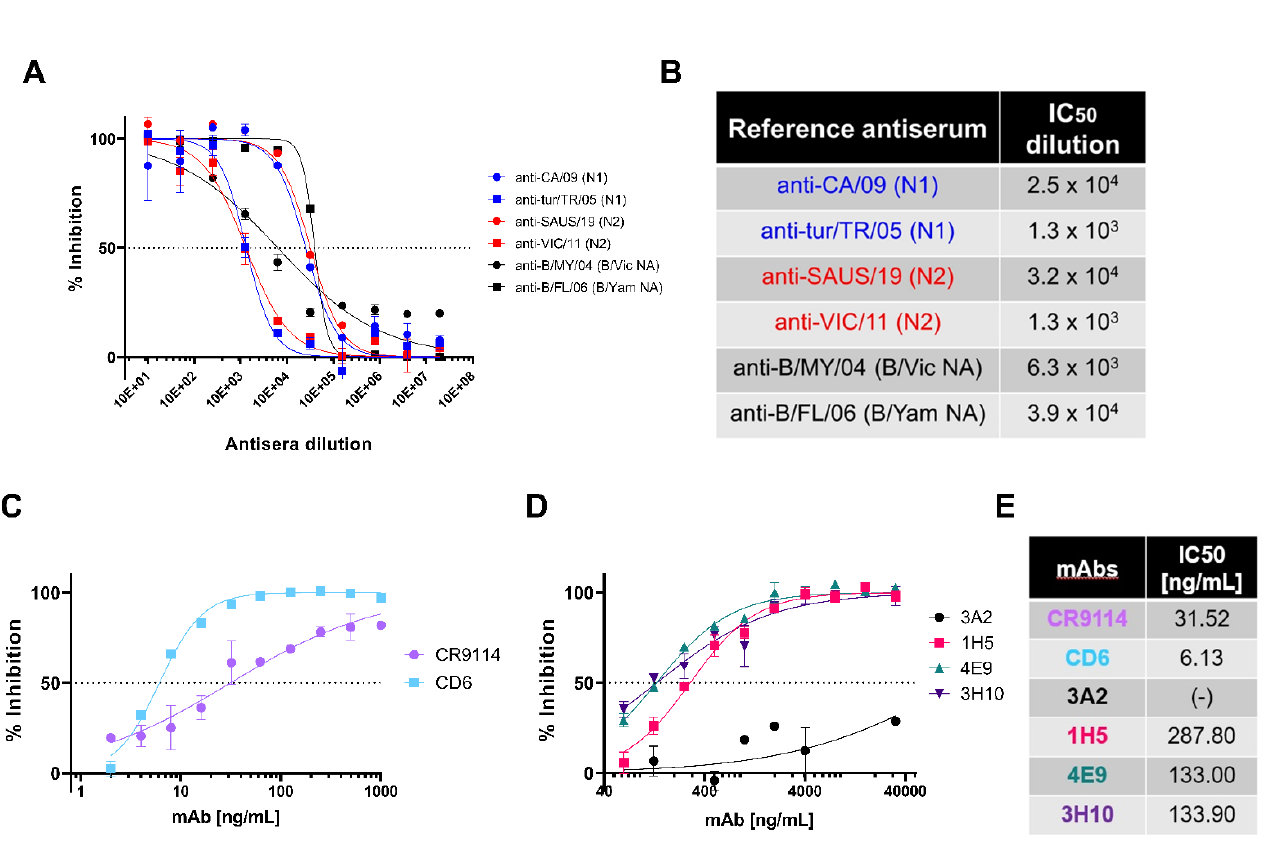
Figure 3. In vitro inhibition of NA pseudotypes by antisera and monoclonal antibodies. ( A ) In vitro inhibition of representative influenza A and influenza B NA pseudotype viruses (PV) which have previously caused human infection: N1 (A/England/195/2009), N2 (A/South Australia/34/2019), B/Victoria-like lineage NA (B/Colorado/6/2017) and B/Yamagata-like lineage NA (B/Phuket/3073/2013), by reference antisera obtained from NIBSC. Reference antisera were serially diluted five-fold from a starting dilution of 1:10 and PV diluted to 90% OD 450 as determined previously from titration (Figure 2C). Inhibition of NA activity was determined via pELLA. Each point represents the mean and standard deviation of two replicates per dilution (n = 2). ( B ) Half-maximal inhibitory dilution of reference antisera as calculated from dose response curves ( A ). ( C ) In vitro inhibition of representative N1 (A/England/195/2009) PV by monoclonal antibodies CR9114 and CD6. mAbs were diluted two-fold from 1000 to 2 ng/mL. ( D ) In vitro inhibition of representative N1 (A/England/195/2009) PV by N1-directed mAbs: 3A2, 1H5, 7E9 and 3H10. mAbs were diluted 2-fold from 32 µg/mL to 32 ng/mL. For ( C ) and ( D ), inhibition was determined via pELLA, and each point represents the mean and standard deviation of two replicates per dilution (n = 2). ( E ) IC 50 concentration values as determined from ( C ) and ( D ) using non-linear regression.